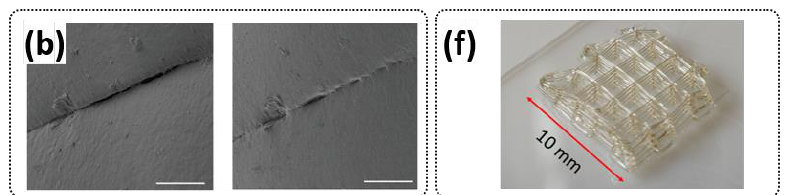
Figure 13. ( a ) Synthesis route of fatty acid-based SHP. ( b ) SEM images of the CPE surface showing the self-healing functionality after 1 h. Scale bar: 100 µm. Reproduced from Reference [101]. ( c ) Schematic for forming the solid electrolyte in polymer matrix membrane (SEPM). ( d ) Enhancement of the gravimetric and volumetric energy densities by moving to an SEPM configuration. Reproduced with permission from [103]. Copyright © 2015 WILEY-VCH Verlag GmbH & Co. KGaA, Weinheim. ( e ) Chemical structures of the materials used for the preparation of 3D-printable CPEs. ( f ) Printed CPE. Reproduced from Reference [105].